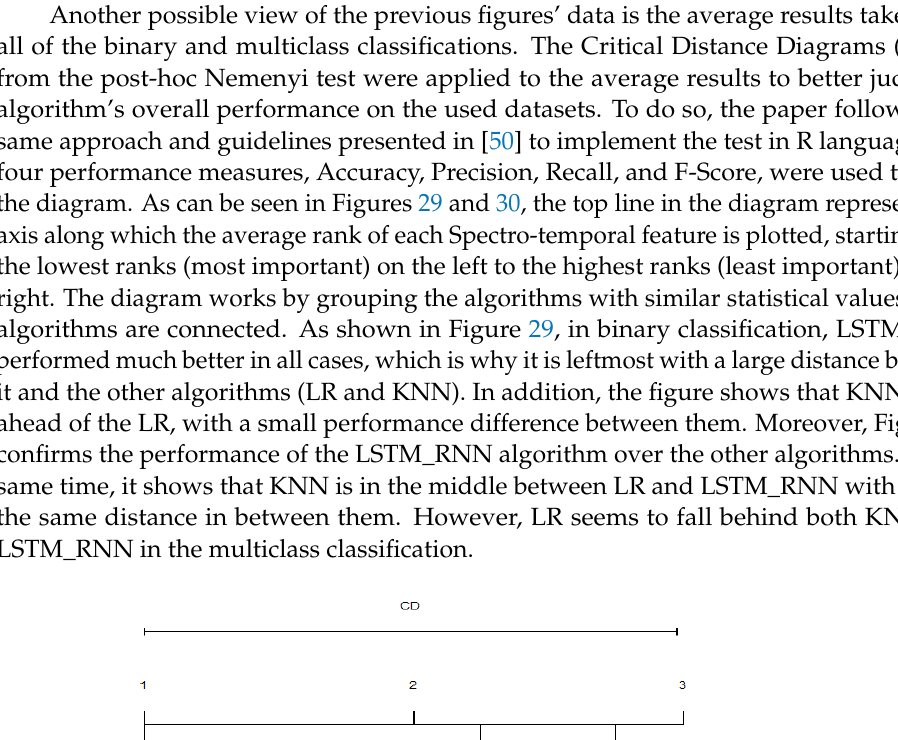
Figure 30. CDD graph for average multiclass classification. 6. Conclusions The field of FANET has gained huge attention in recent years. It has been used in many civilian and military applications. However, there is still a gap in their securities. Current cryptography techniques might not be appropriate due to their complexities and power cost. Moreover, intrusion into such flying robots could be more dangerous than jamming or message interception. Therefore, this paper is considered one step towards an intelligent intrusion detection framework for Drones. The framework is based on two separate components: the drone and the Base station. It utilizes a particular type of RNN for both components, which is RNN-LSTM. The results showed superior performance with average performance, almost 15 on average, over some of the recent algorithms. One of the main restrictions of this paper is applying the proposed framework over real FANET. This is one of the future works following this paper. Another future direction is secure communication between the drones and the base station as well as between the drones themselves. In our future work, we intend to extend the proposed framework in this paper by implementing a lightweight algorithm based on a linear hyperbolic chaotic system of partial differential equations. The chaotic system is mainly applied to drones and satellite communication. Moreover, examining the cyberattacks against the application-layer communication of drones using different methods could be another interesting work to be conducted in a separate paper.